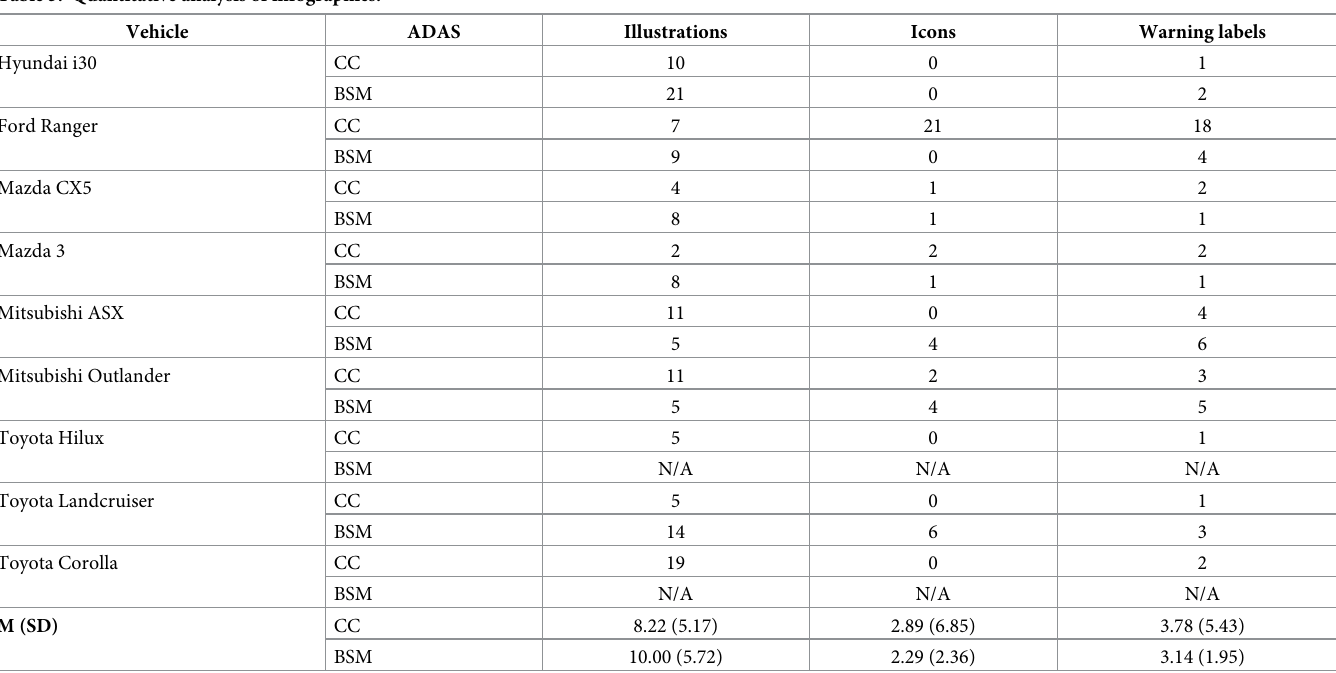
Table 5. Quantitative analysis of infographics.